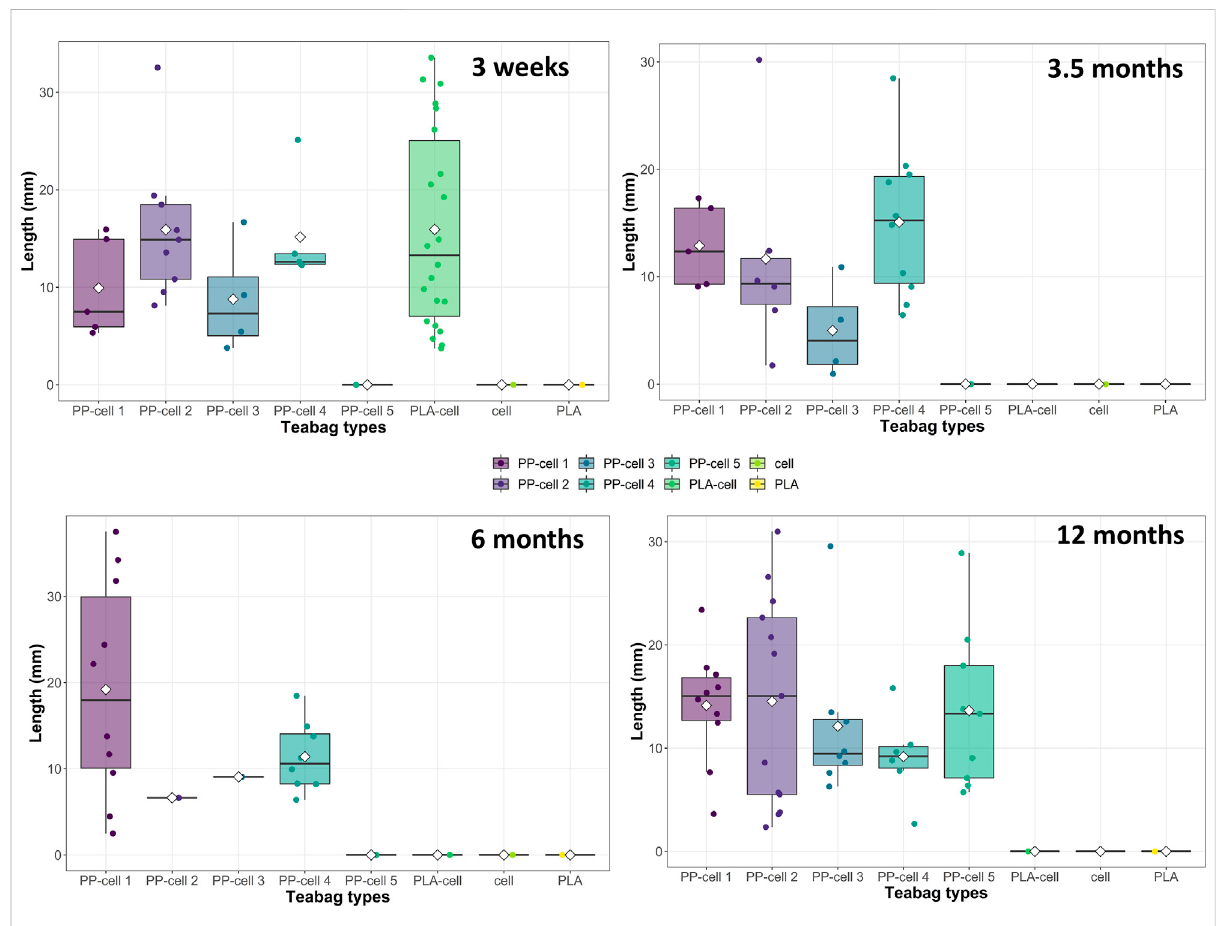
FIGURE 5 Total number and length of fragments produced by each teabag type over